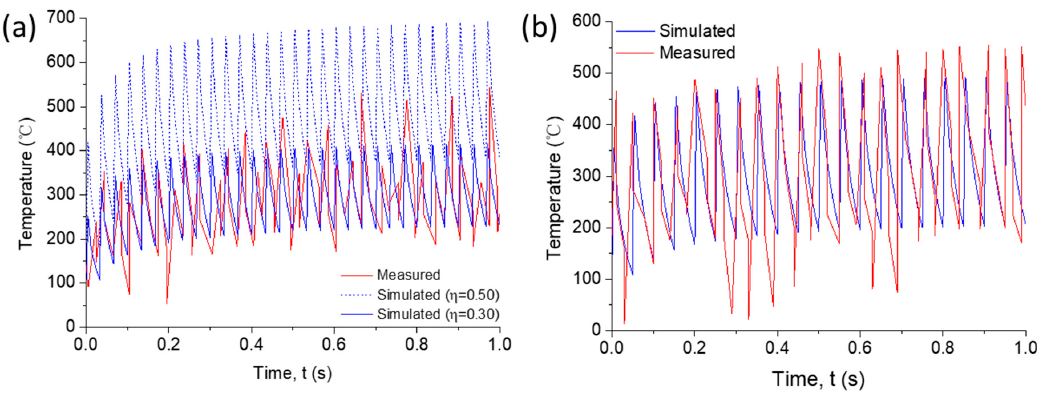
Figure 5. Comparison of experimental and simulation temperature curves: ( a ) calibration and ( b ) validation.